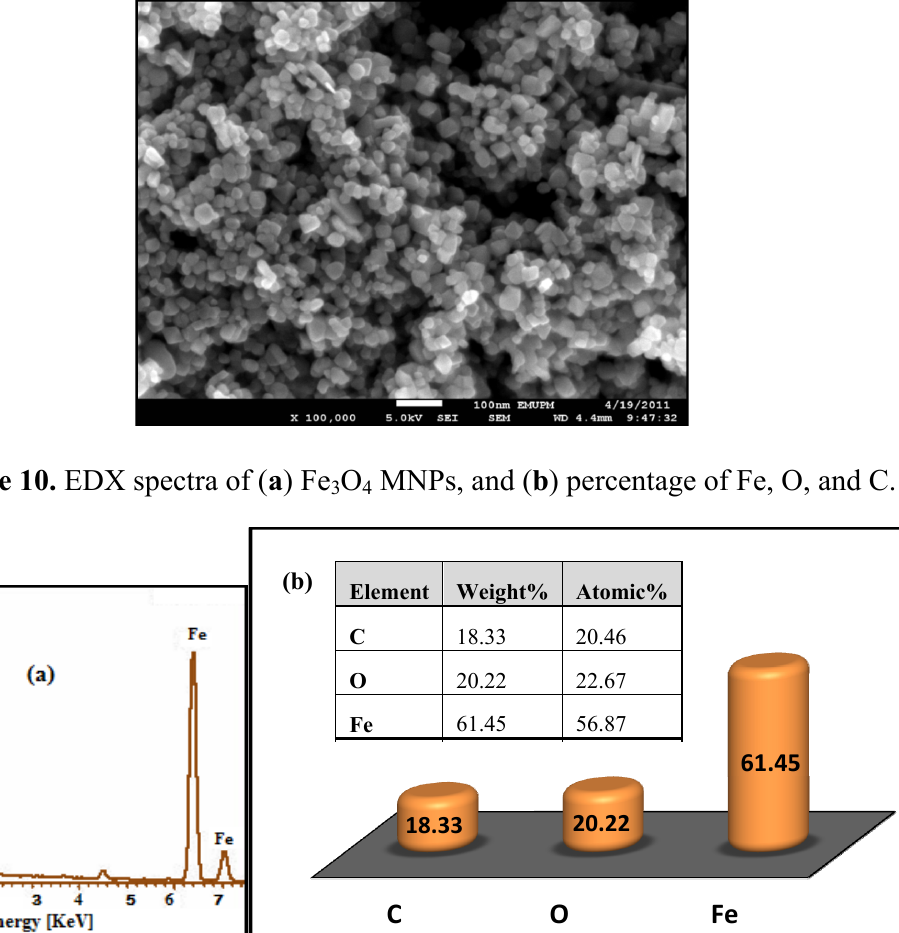
Figure 9. SEM micrograph of oleic acid modified Fe